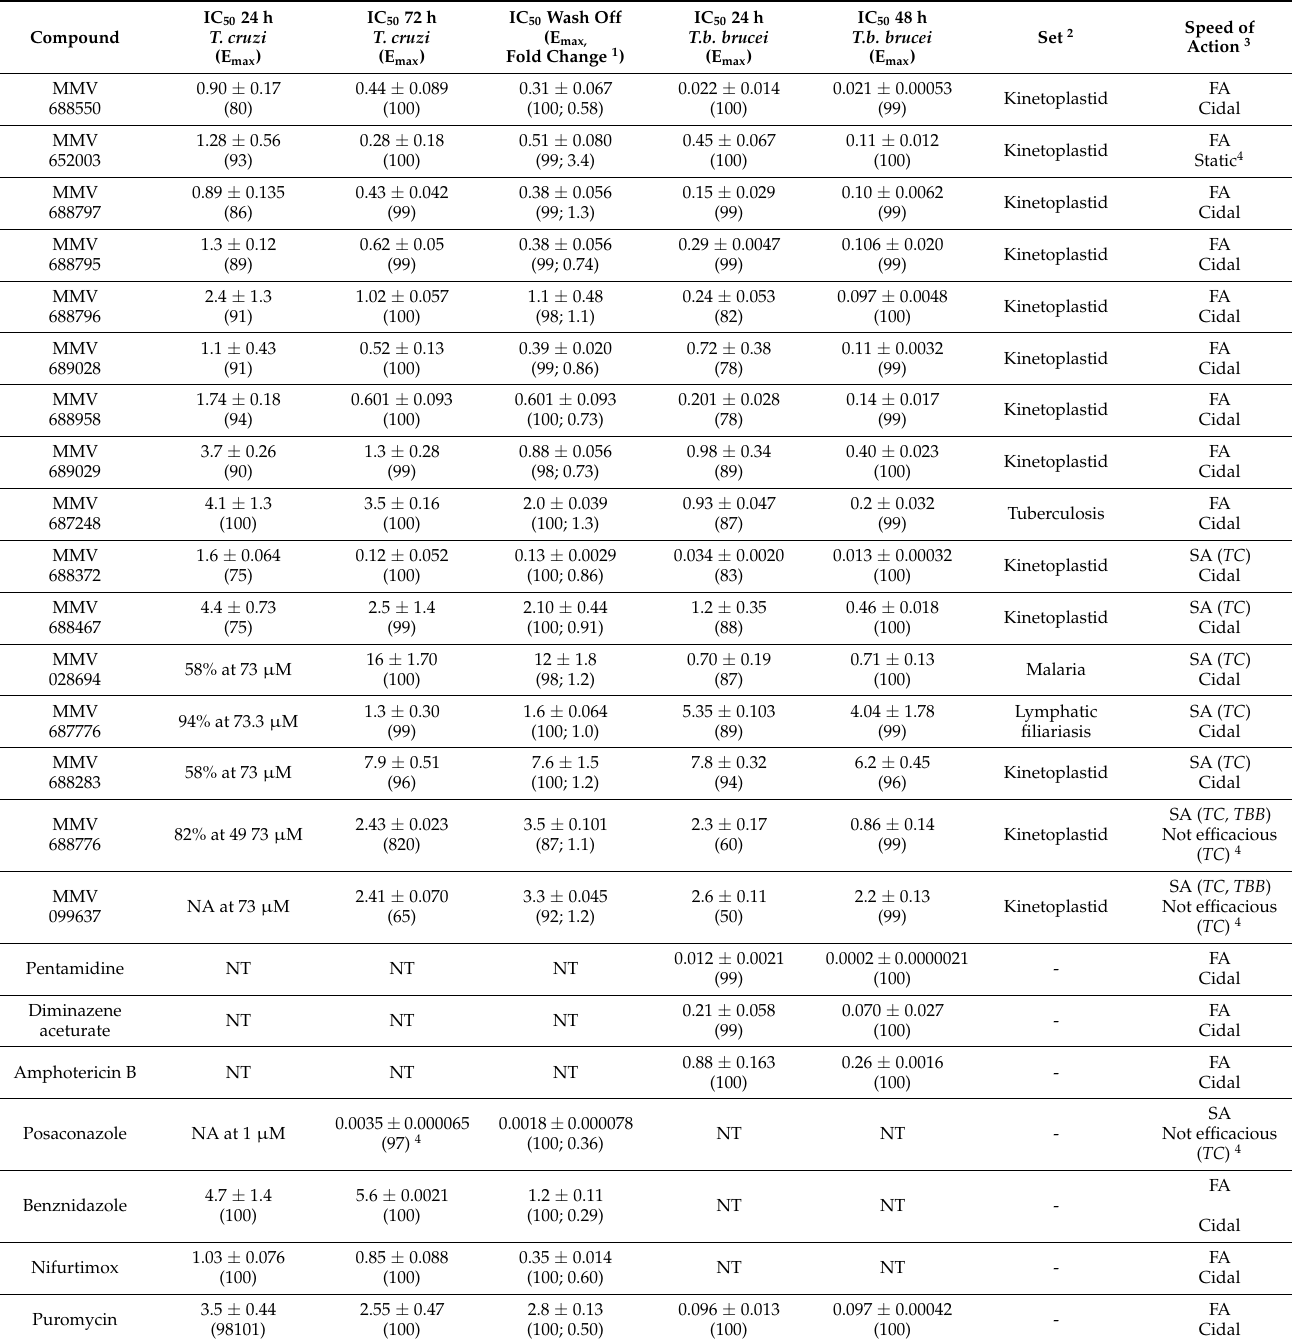
Table 2. IC 50 values and maximum activity (E max ) of compounds with activity against T. cruzi and T.b. brucei following 24–72 h exposure; in addition to compound wash off in the T. cruzi